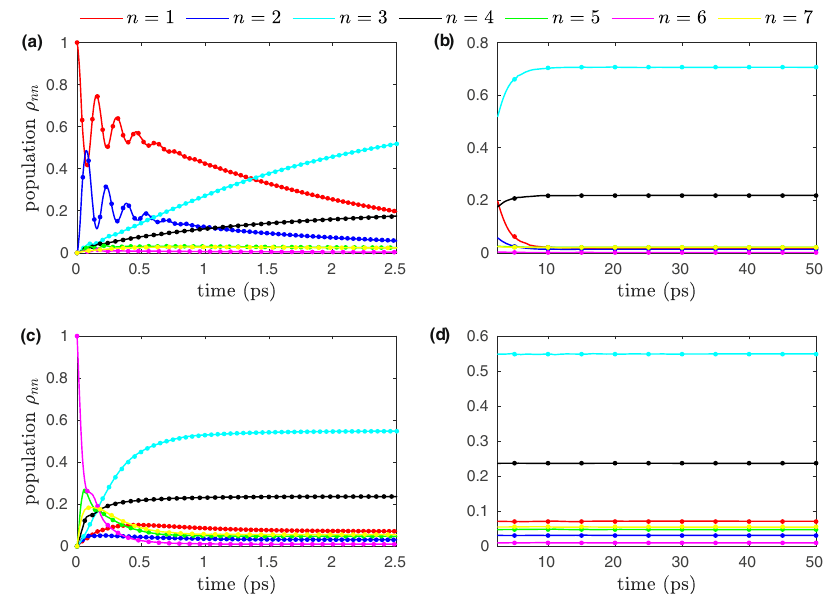
Fig. 2 Population of the seven sites in the FMO complex as a function of time. In a , b , the initial excitation is considered on site-1 and other parameters are γ = 175, λ = 70, T = 70. In c , d , the initial excitation is on site-6 and other parameters are γ = 75, λ = 100, T = 130. a and c show a part of the population up to 2.5 ps, while the population changes beyond 2.5 ps are shown in ( b ) and ( d ), from which it is clearly seen that the population plateaus after a few picoseconds. The off-diagonal terms or coherences are shown in Fig. 3. The results of AI-QD are compared to the results of LTLME-QD (dots). n is the site label. γ and λ are in the units of cm − 1 , while T is in the units of K.